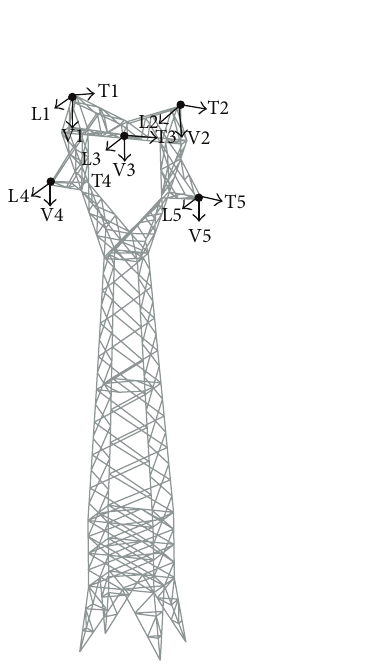
Figure 16: Loading points of studied tower 2.